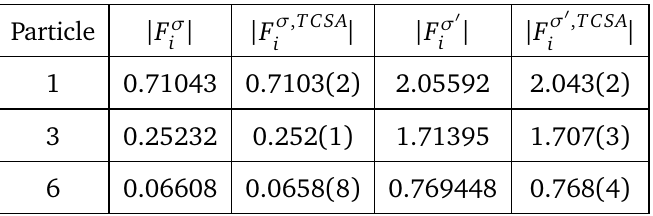
Table 6.1: One-particle form factors of the magnetisation operators, TCSA vs. form factor boostrap.. The digits in parentheses indicate the error in the last digit of the TCSA data, which is estimated from the stability of the exponential fit under the choice of the volume window. Note that the deviations in the subleading magneti- sation data are an order of magnitude worse then for the leading one, and also that TCSA estimates of matrix elements involving higher particles are generally less ac- curate due to truncation errors, as discussed in Appendix